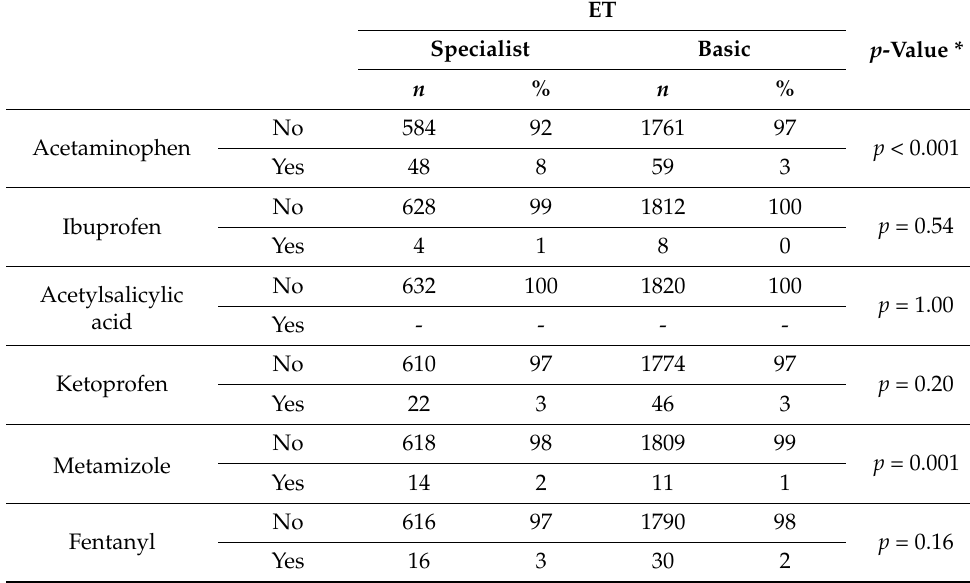
Table 4. The intake of individual analgesics and sedatives administered by specialist and basic ETs.